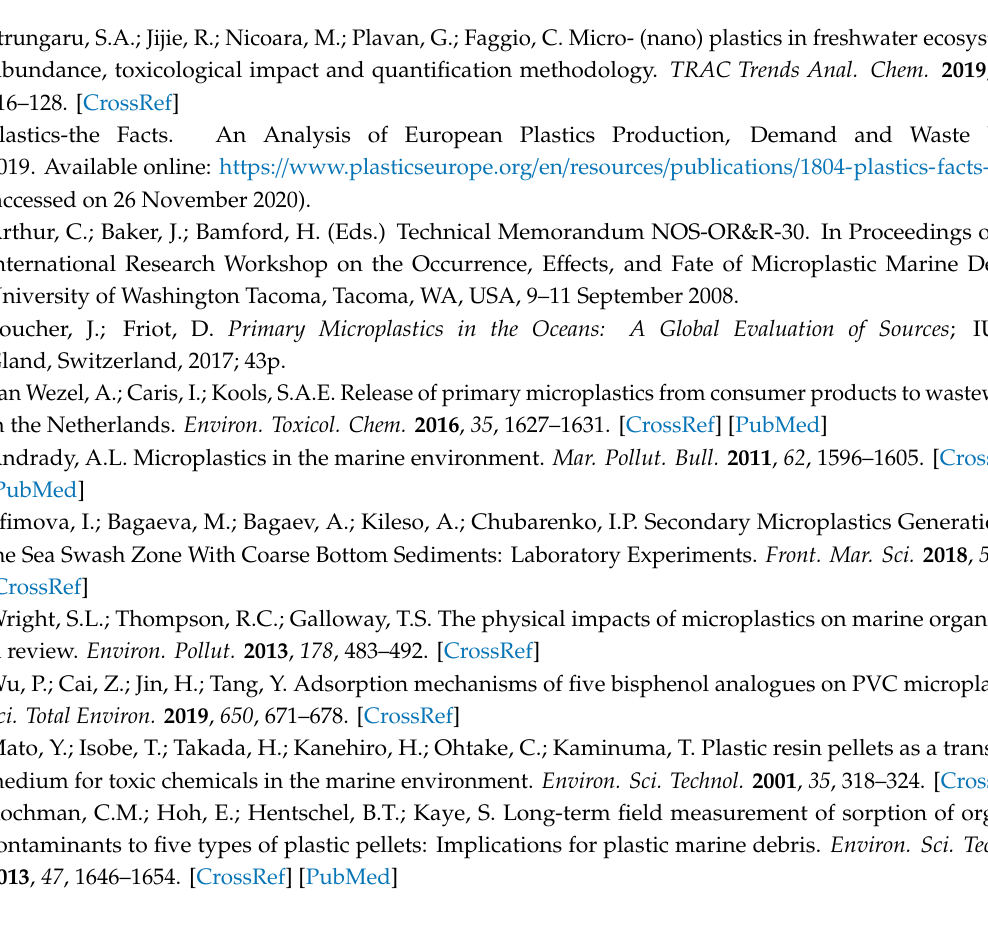
Figure S1: Schematic representation of the microsphere fabrication device, Figure S2: Flowchart of the optimized enzymatic digestion protocol used, Figure S3: Solutions for the density gradient, Figure S4: FT-IR of PVC-PtOEP MPs, Figure S5: Soft tissues after dissection from mussels to assess PVC-PtOEP MPs bioaccumulation, Figure S6: Images of matrix obtained by two di ff erent enzymatic digestion